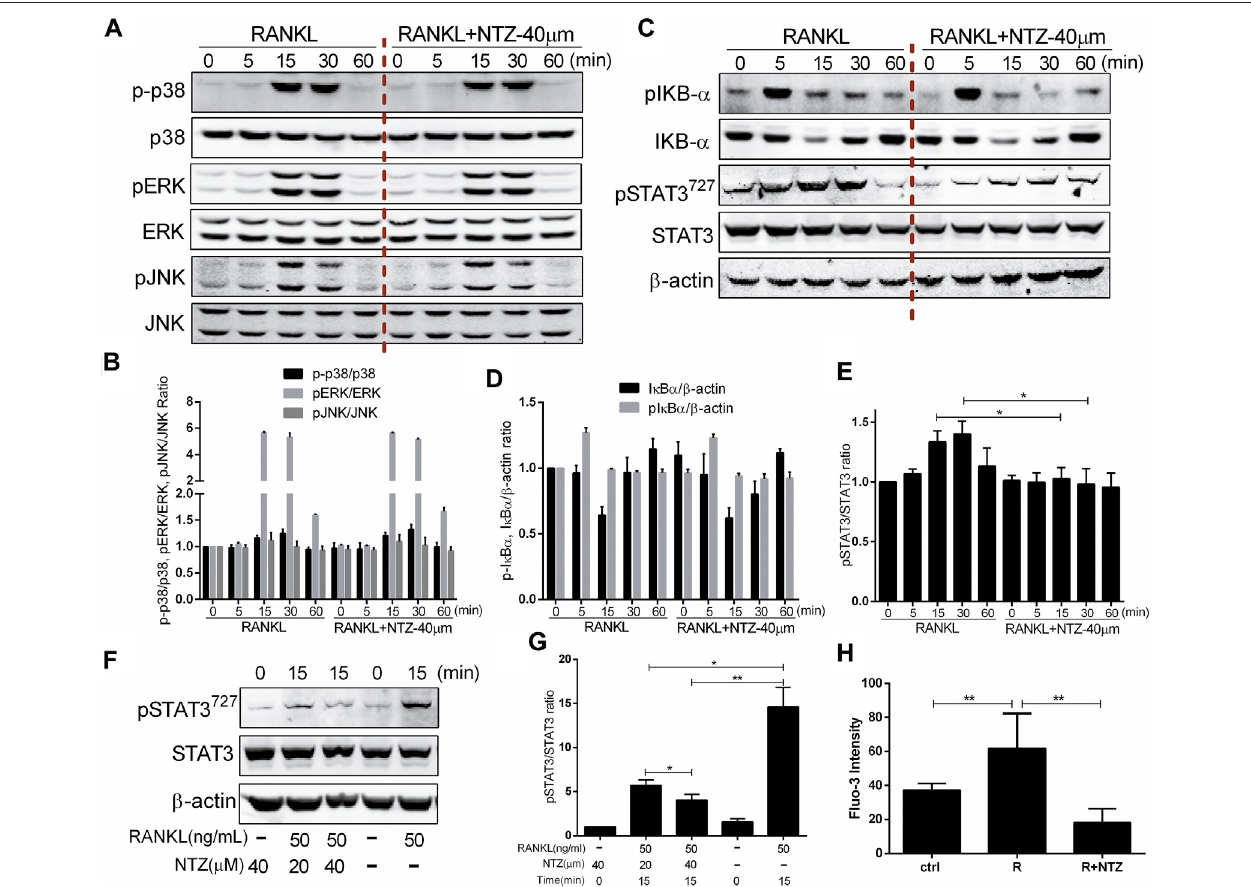
FIGURE 5 | Nitazoxanide impaired RANKL-induced STAT3 phosphorylation and reduced Ca2+ fl uorescence intensity. (A) RAW264.7 cells were treated with or without 40 µM NTZ for 2 h and then treated with 50 ng/ml RANKL for the indicated periods. Cell lysates were analyzed using immunoblotting. The expression of phosphorylated p38, ERK and JNK was evaluated. Total JNK, p38 and ERK levels were used as loading controls. (B) The relative ratios of p-p38, pERK and pJNK to theirnon-phosphorylatedforms were quanti fi ed byImageJ. (C) Cells were treatedas in (A) , celllysates wereanalyzedusing western blotting. ExpressionofpI κ B α , I κ B α , pSTAT3 and STAT3 were evaluated. β -actin was used as a loading control. (D) The quantitative analysis of pI κ B α and I κ B α expression between the NTZ-treated group and control group. (E) The quantitative analysis of pSTAT3/STAT3 expression between the NTZ-treated group and control group. (F) RAW264.7 cells were pretreated with NTZ for 2 h, and RANKL wassubsequently added for 15 min pSTAT3 and STAT3 weredetected. β -actin was used asaloadingcontrol. (G) The relative ratiosofpSTAT3toSTAT3werequanti fi edbyImageJ. (H) RAW264.7cellsweretreatedwith50 ng/mlRANKL,withorwithout40 µMNTZfor48 h.Fluo-3intensitywas analyzedusingimmuno fl uorescence.Themeanchangeincalciumintensitypercellineachgroup.Errorbarsrepresentmean ± SDfromthreeindependentexperiments. ctrl, control; NTZ, nitazoxanide; R, RANKL. * p value ＜ 0.05, ** p value ＜ 0.01.